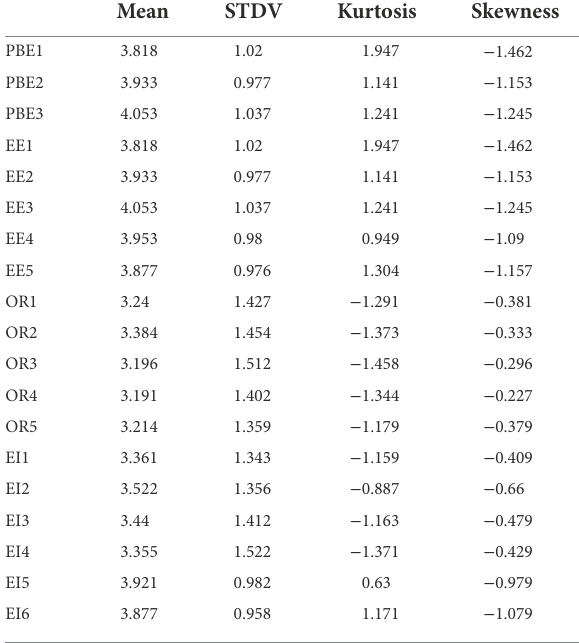
TABLE 2 Descriptive statistics of